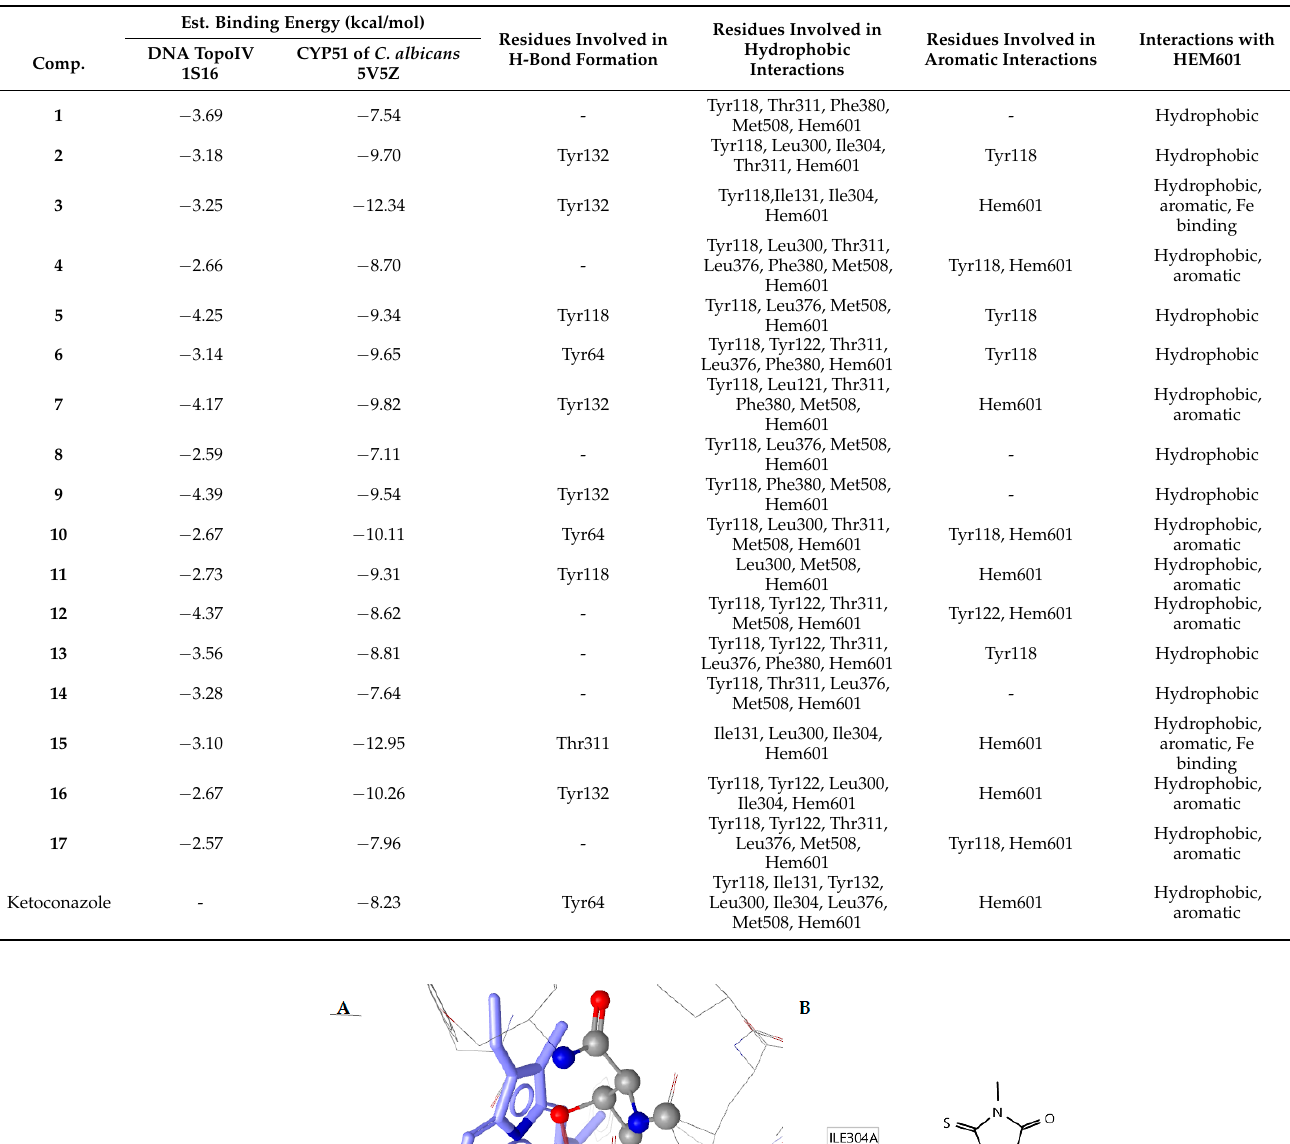
Table 5. Molecular docking free binding energies (kcal/mol) to antifungal targets.